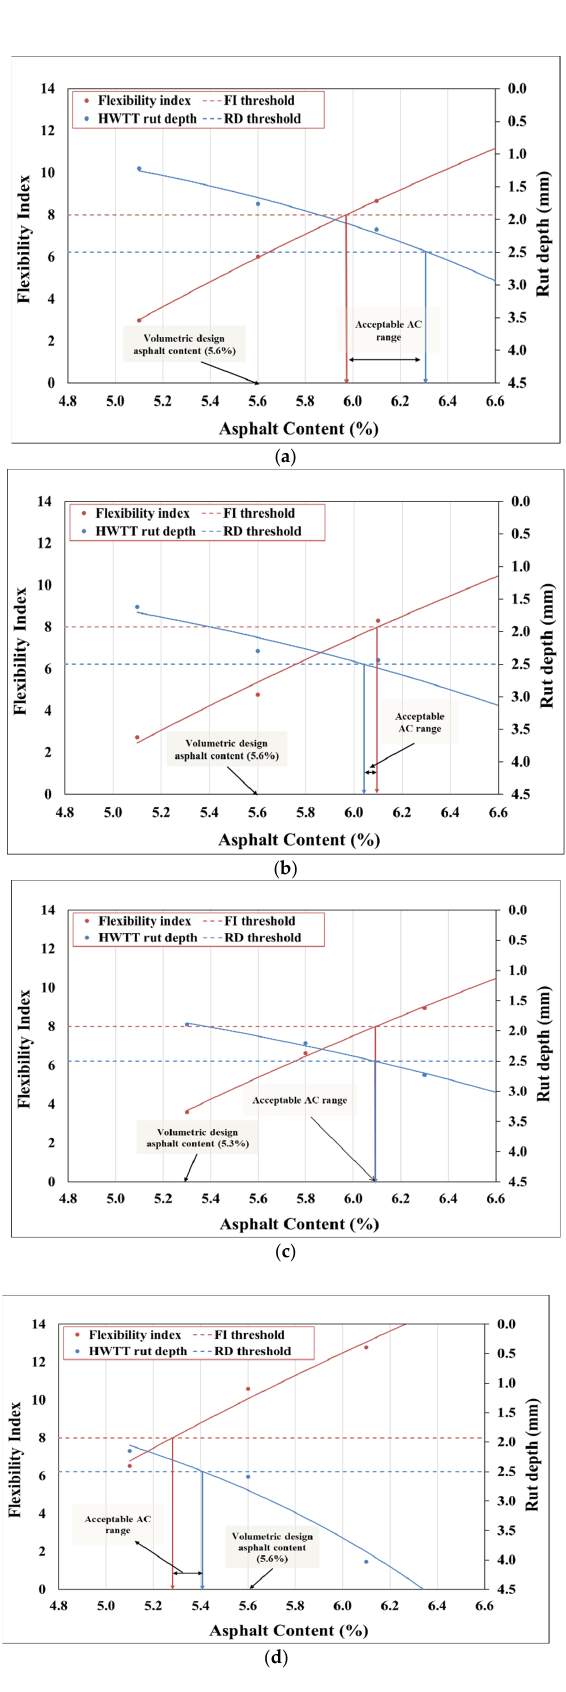
Figure 4. Balanced mix design for ( a ) Mix1_AV5, ( b ) Mix1_AV7, ( c ) Mix2, and ( d ) Mix3.